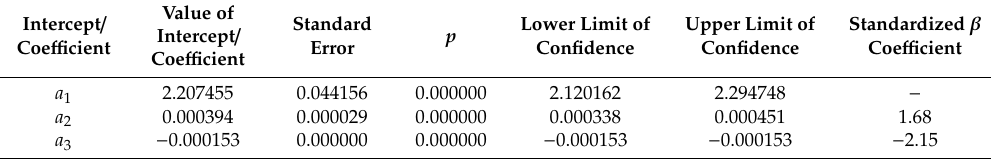
Figure 16. Visualization of 3D model of H:C ratio of torrefied pruned biomass (model 2). Table 14. Statistical evaluation of H:C ratio model of torrefied pruned biomass (model 2).